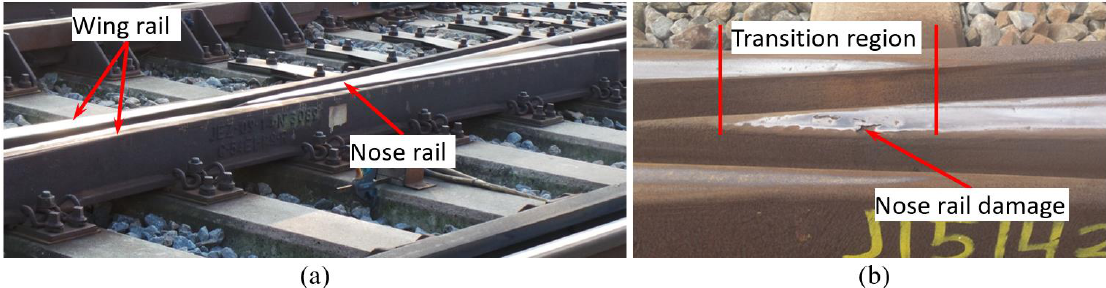
Figure 2. A 1:9 cast manganese steel crossing: ( a ) view of a wing rail and crossing nose rail, and ( b ) crossing nose rail damage in the transition region.